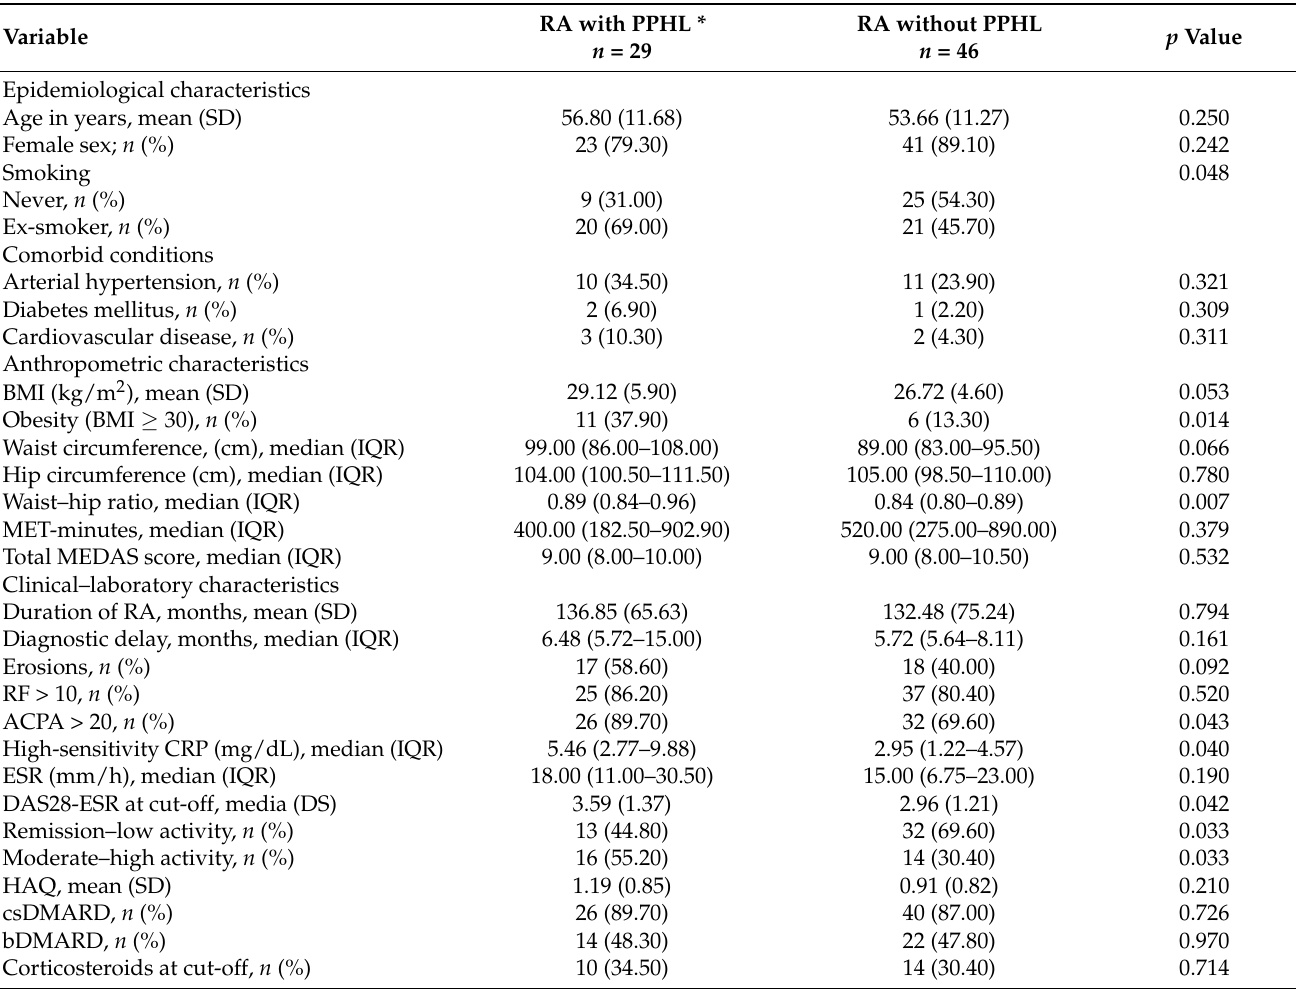
Table 4. Clinical characteristics, cIMT, and cytokine profile associated with postprandial hyperlipi- demia in patients with rheumatoid